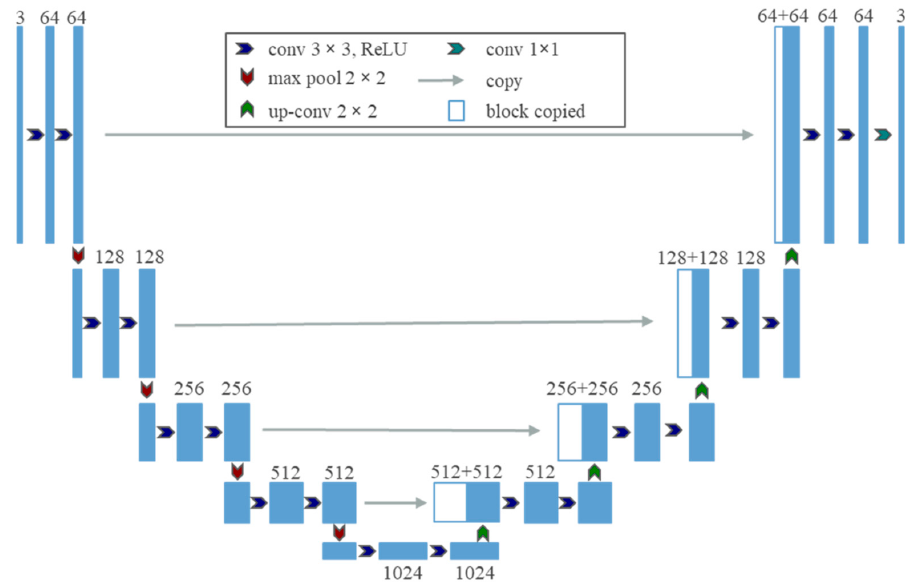
Figure 11. The framework of U-Net.